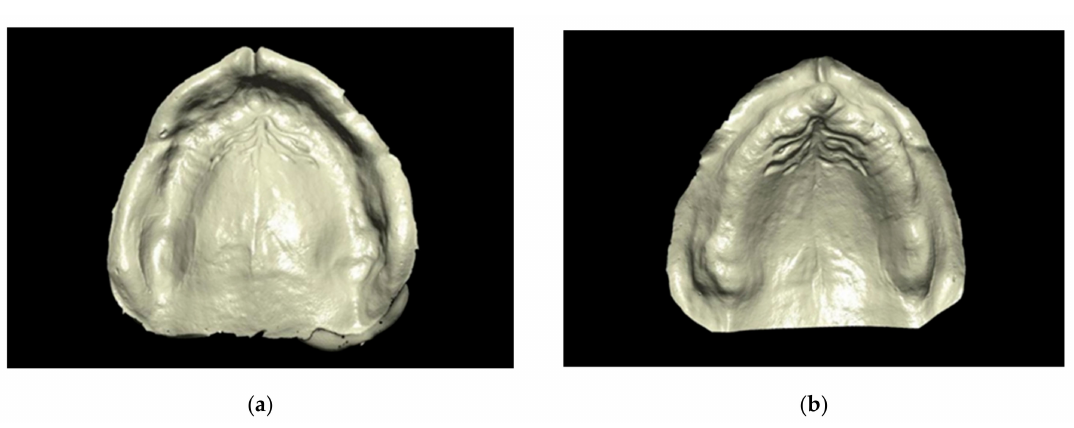
Figure 4. ( a ) Scan of a physical impression obtained from the extraoral laboratory scanner; ( b ) Digital model obtained from the inversion of the scan of a physical impression.